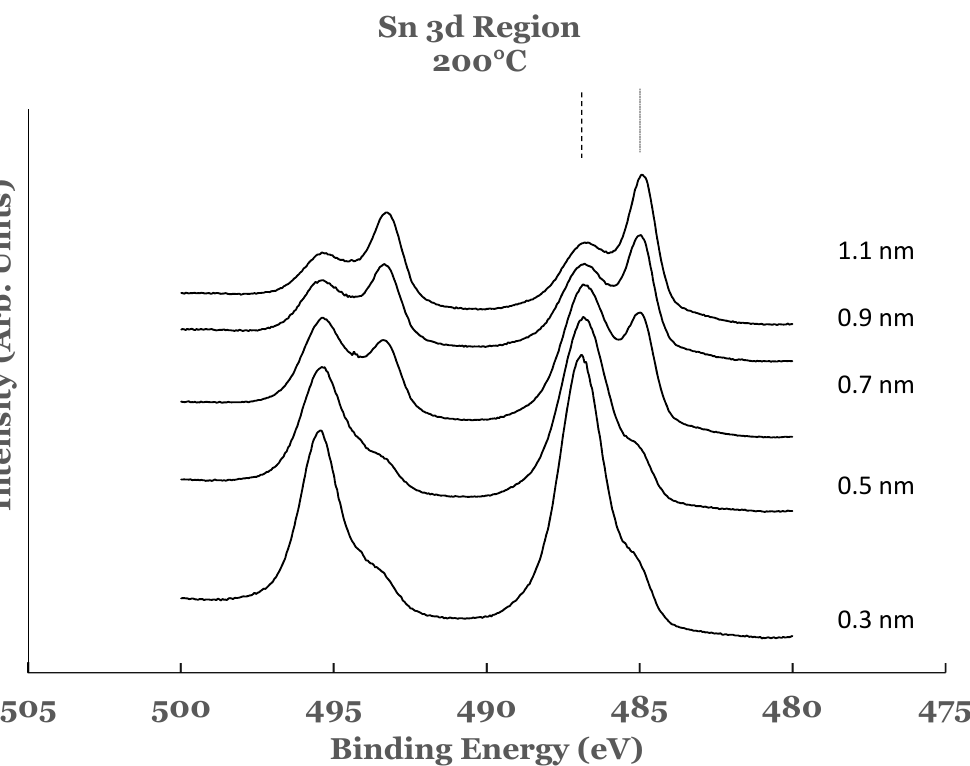
Figure 7. Spectral data in the Sn 3d region as a function of the titanium overlayer. The overlayer was deposited at the substrate temperature of 200 °C. The vertical lines represent the positions of the 3d 5/2 core level. The solid line corresponds to elemental Sn while the dashed line to SnO 2 . The amounts of SnO 2 and elemental Sn at the interface were estimated for these sam-ples also. For this purpose a curve fit to the spectral data was performed as explained ear-lier. An example of curve fit is given in Figure 8 for the 1.1 nm of titanium on SnO 2 . The relative percentages of SnO 2 and elemental Sn were determined from the areas of the cor-responding fitting curves, normalized to the total area of the 3d peak. Plots of the percent-age compositions of SnO 2 and elemental Sn, thus determined as a function of the thickness of the titanium overlayer, are also included in Figure 3a,b. The dashed lines serve as a guide to represent the trend in the data. For these samples, a decreasing trend in SnO 2 while an increasing trend in elemental Sn are observed with the increase in the titanium overlayer. Some differences exist when comparing these data with the room temperature data. The SnO 2 concentration starts from a higher value in such samples and continues to show a decreasing trend for thicknesses greater than 0.9 nm. Similarly, the elemental Sn starts from a lower value and continues to show an increasing trend. The data from these